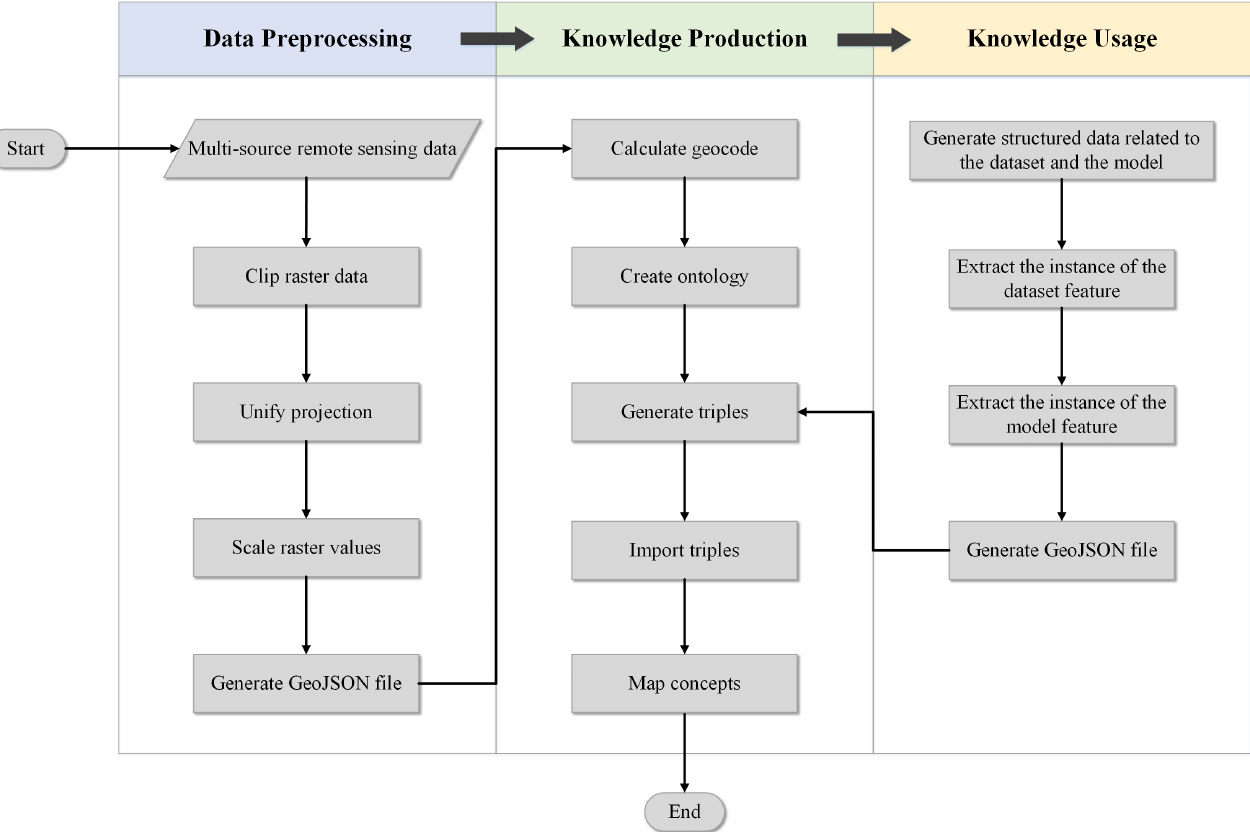
Figure 5. The process of producing knowledge from data in the knowledge graph